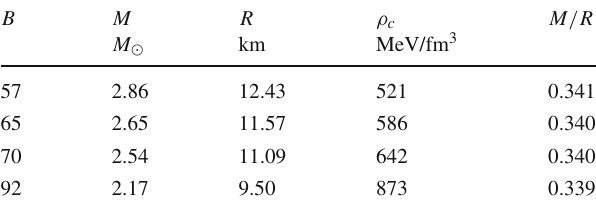
Table2 Propertiesofquarkstarsin f ( R , T ) gravityfordifferentvalues of bag constant B . All parameters for calculations are chosen according to the discussion given in Fig. 2